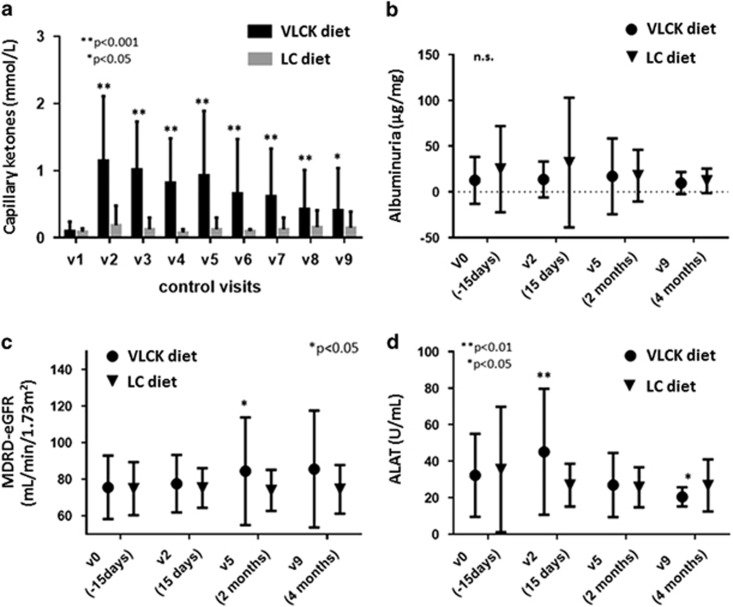
Diet-induced changes in safety parameters in the very low-calorie-ketogenic (VLCK) diet and low-calorie (LC) diet groups. (a) Changes in capillary ketones. (b) Changes in albuminuria. (c) Changes in estimated Glomerular Filtration Rate using MDRD study equation (MDRD-eGFR). (d) Changes in ALAT. *P-value<0.05: all cases, between-group comparisons conducted by ANOVA.